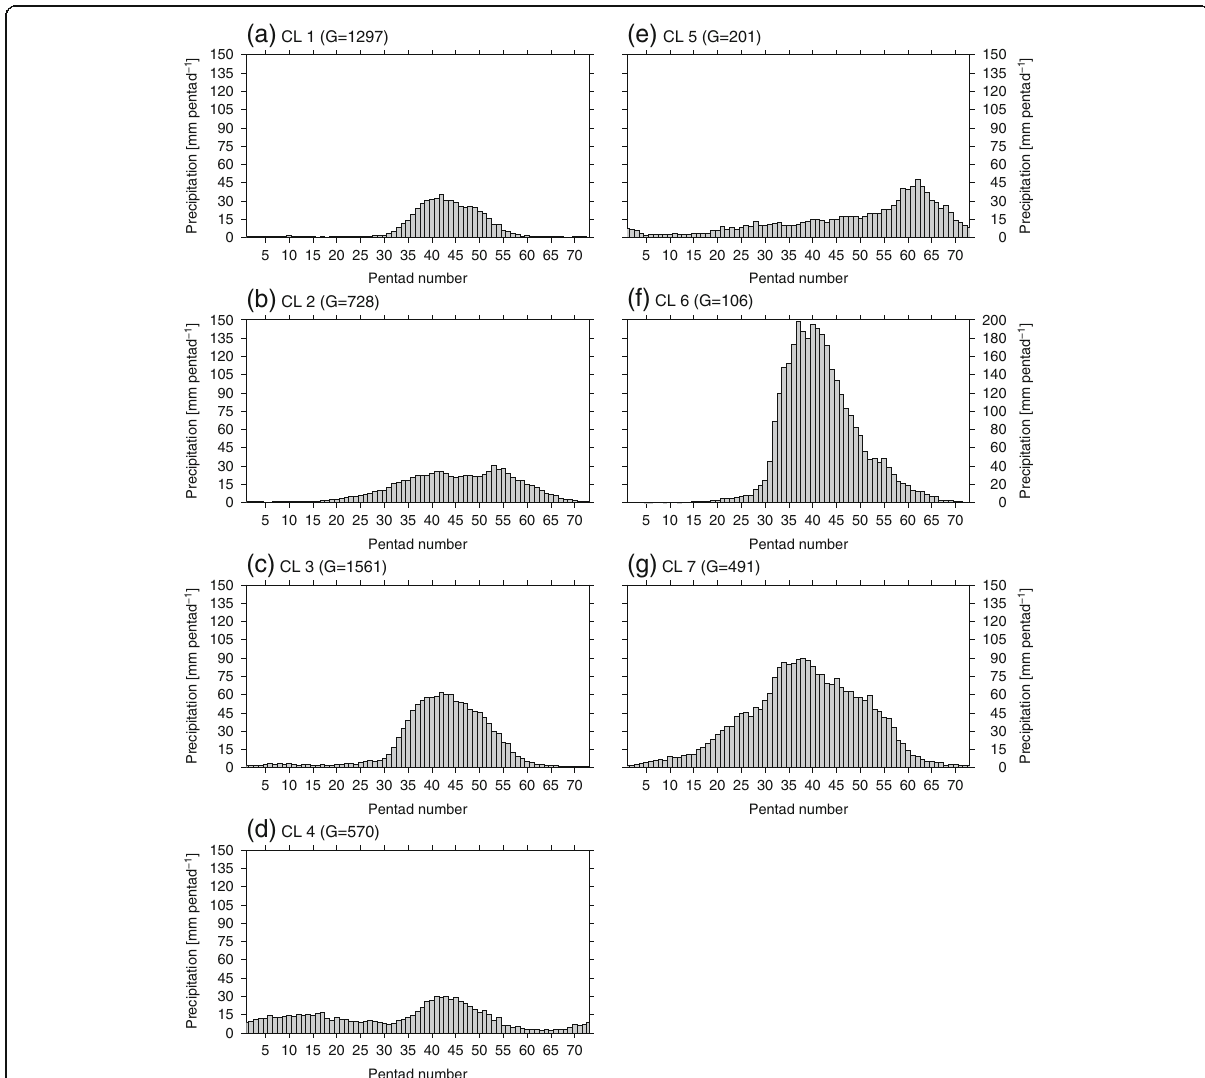
Fig. 3 Seasonality of the pentad-mean precipitation for each cluster. The pentad-mean precipitation averaged for 1901 – 2013 in CL1 ( a ), CL2 ( b ), CL3 ( c ), CL4 ( d ), CL5 ( e ), CL6 ( f ), and CL7 ( g ). Horizontal axis represents pentad number (P) for the